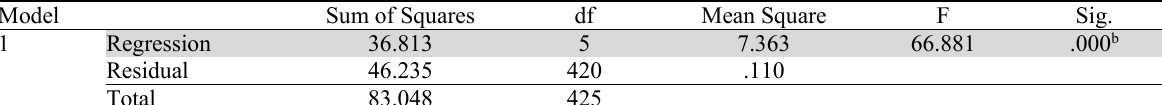
ANOVA coefficient a Model